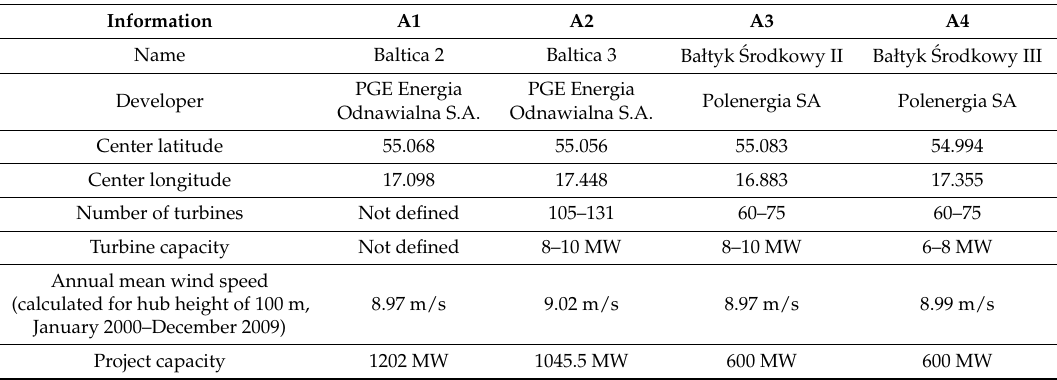
Table 3. Basic information about the considered locations for offshore wind farms in the Polish economic zone in the Baltic Sea.